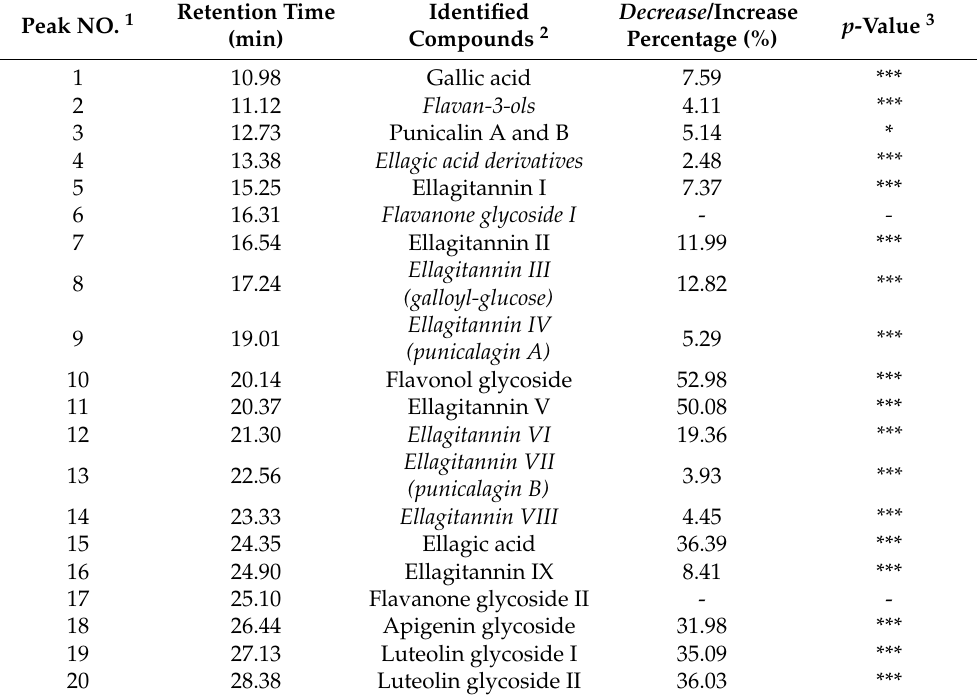
Table 2. The polyphenolic profile of pomegranate leaf infusion at 0 h of storage by RP-HPLC-DAD as well as their respective retention times and decrease or increase percentage (%). Decrease /Increase Retention Time Identified p -Value 3 Peak NO. 1 (min) Compounds 2 Percentage (%) 1